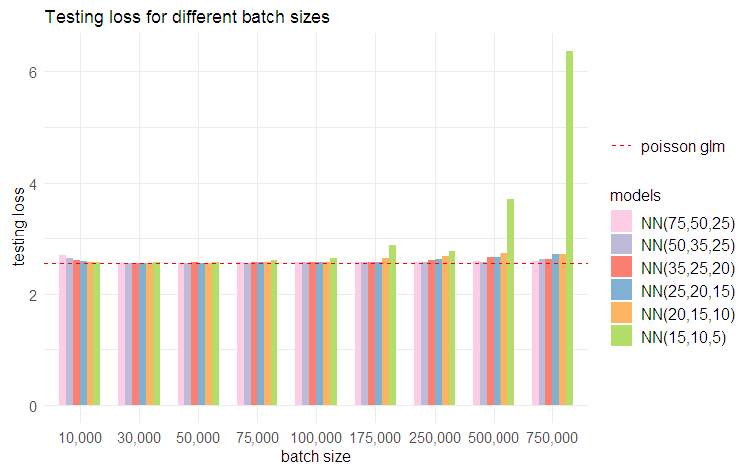
Figure 8. Change in the deviance testing (out-of-sample) loss for the Poisson neural network models with different architectures as batch size